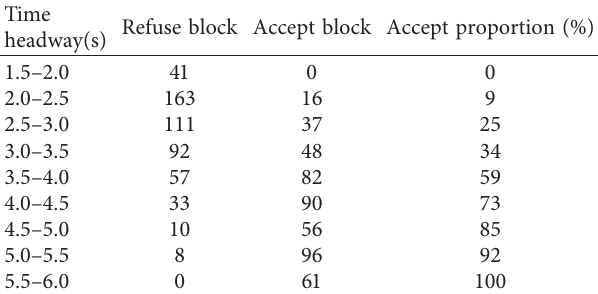
Table 4: Gap accepted by nonmotor vehicles [33].